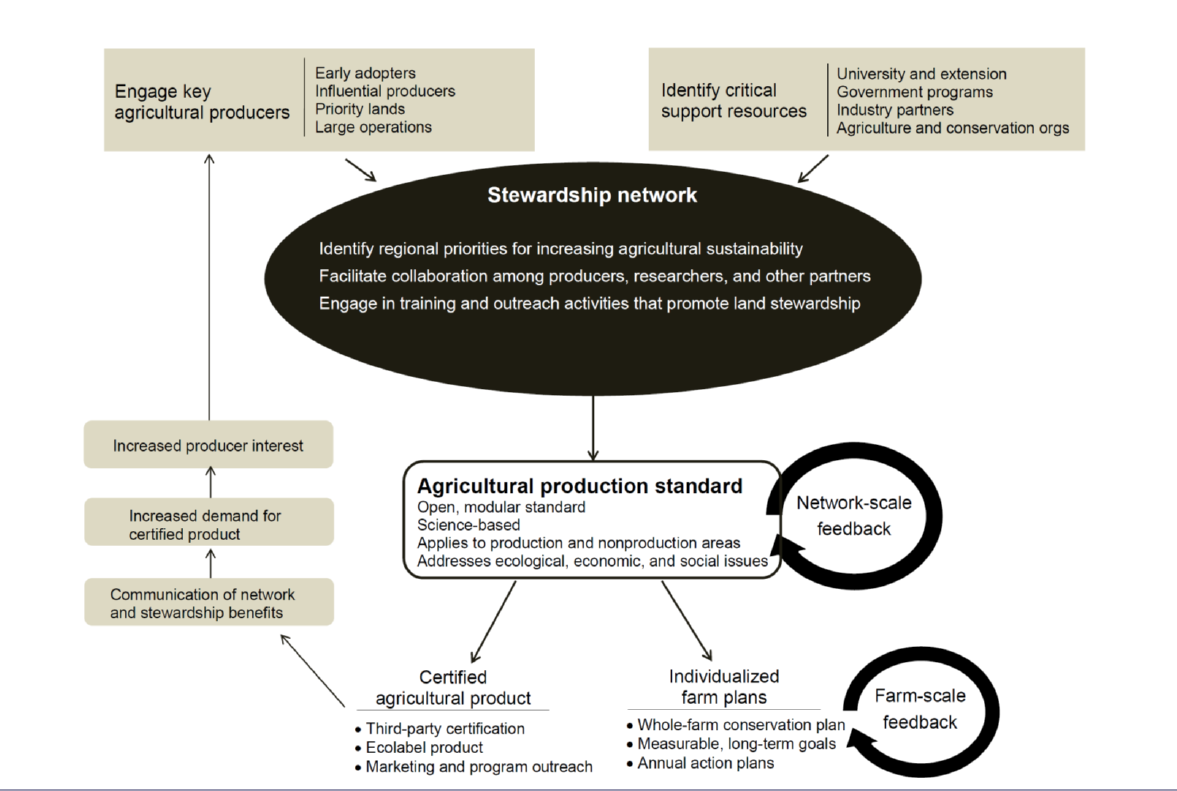
Fig. 2 . The Capacity-Building Stewardship Model. Note that while the certified agricultural product is described as one result of the process, other products of the agricultural production standard, which applies to both production areas and nonproduction areas, include improved ecological services and biological diversity conservation. If the marketing of the certified agricultural product is successful in securing a price premium, this will facilitate expansion of the program to landscape scales that are ecologically